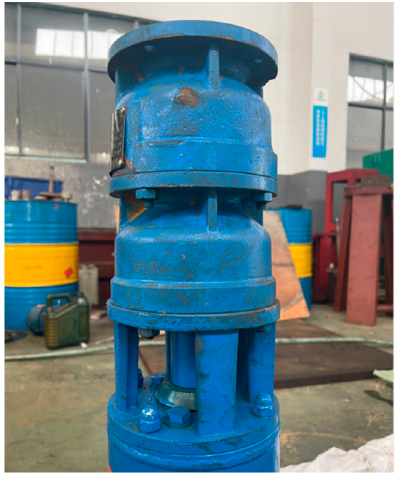
Figure 26. Test pump.